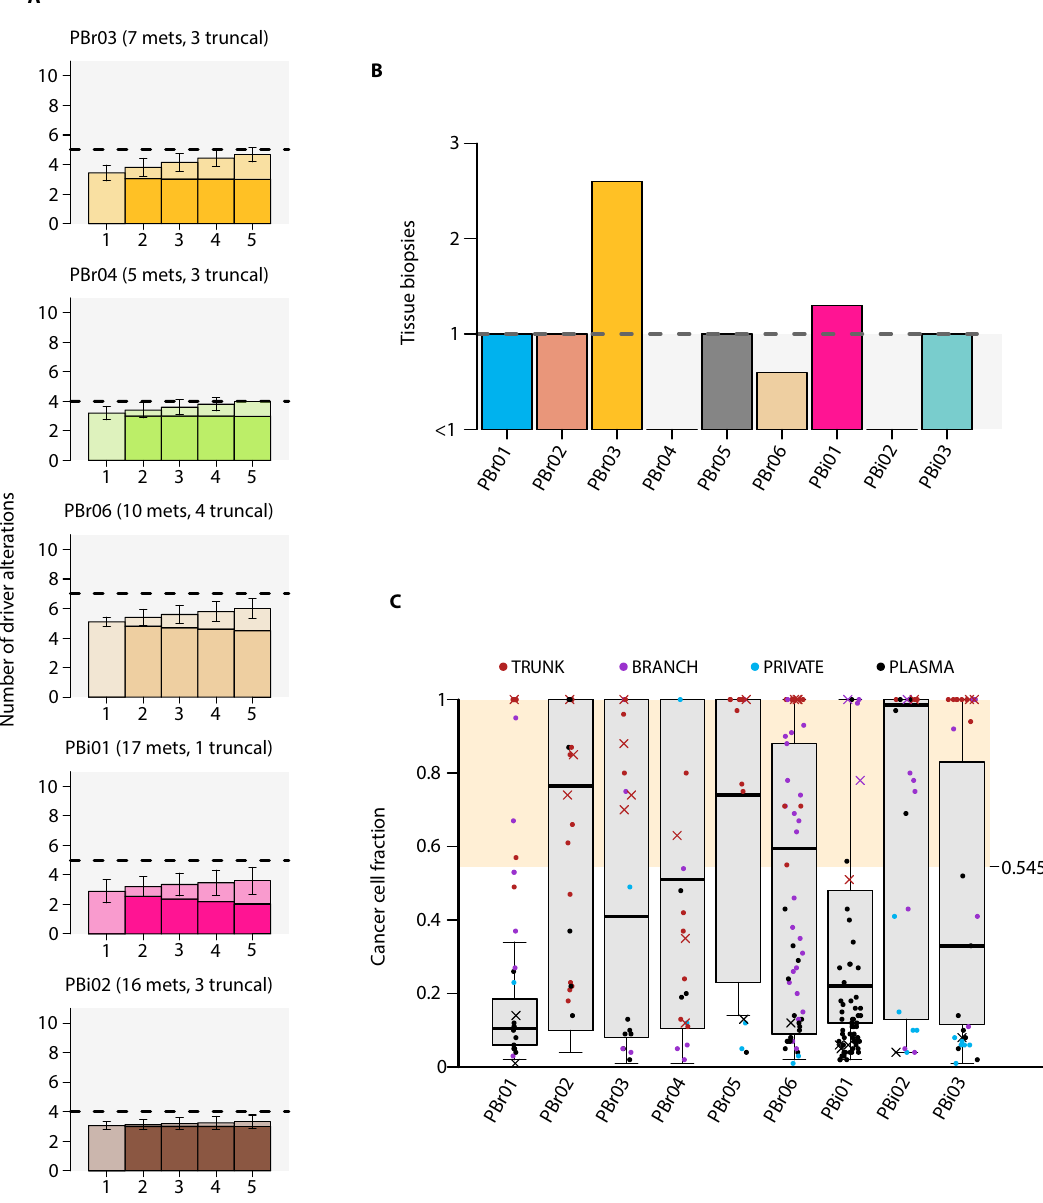
Fig. 5 Functional alteration identi fi cation in tissue and cfDNA. A The average number of functional alterations (mutations and SNCAs) identi fi ed when sampling all possible combinations of one to fi ve tissue samples from each patient are shown. For between two and fi ve tissue samples, dark colors indicate alterations detected in lesions sampled, whereas transparent colors indicate alterations present in only a subset of the sampled lesions. The actual number of driver alterations (i.e., across all lesions) is indicated by dashed lines. The number of metastases sampled from a patient and the actual number of truncal driver alterations is noted above each plot. Errors bars indicate standard deviation in the number of detected mutations across all combinations of between one and fi ve tissue samples. Only patients with at least one non-truncal functional alteration are shown (results for the remaining patients can be found in Supplementary Fig. 14A). B The number of driver alterations identi fi ed in each plasma sample compared to the number of alterations identi fi ed when sampling one to fi ve tissue biopsies. “ <1 ” indicates cases where more driver alterations are identi fi ed in a single tissue sample than in plasma sample. For two patients, more driver alterations are identi fi ed in the plasma sample than in a single tissue sample. C A threshold for distinguishing between truncal and non-truncal sSNVs was calculated using ROC analyses on the combined set of sSNVs in the nine cfDNA samples. Trunk, branch and private sSNVs are shown for each patient against the obtained threshold. Driver sSNVs are indicated by “ X ” points. Boxplots show the CCF distributions of sSNVs for each patient: the whiskers span the maximum and minimum CCF values, the box spans the upper and lower quartiles, and the center represents the median sSNV CCF observed for a